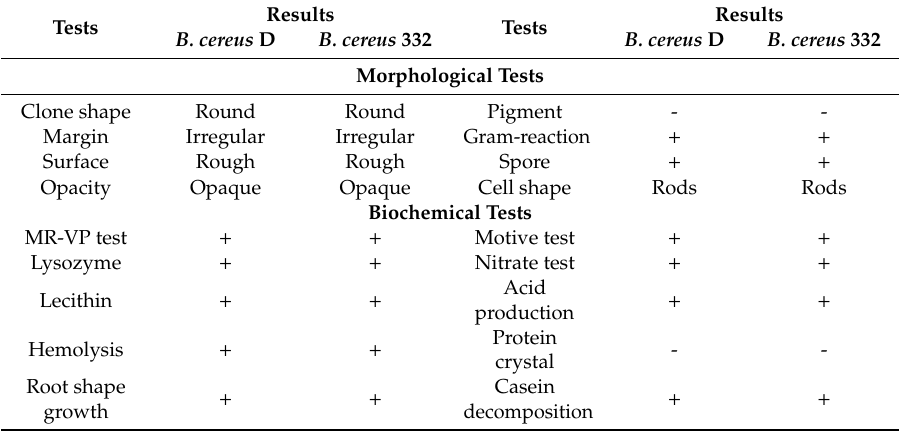
“ + ” indicates positive results and “-” indicates negative results.